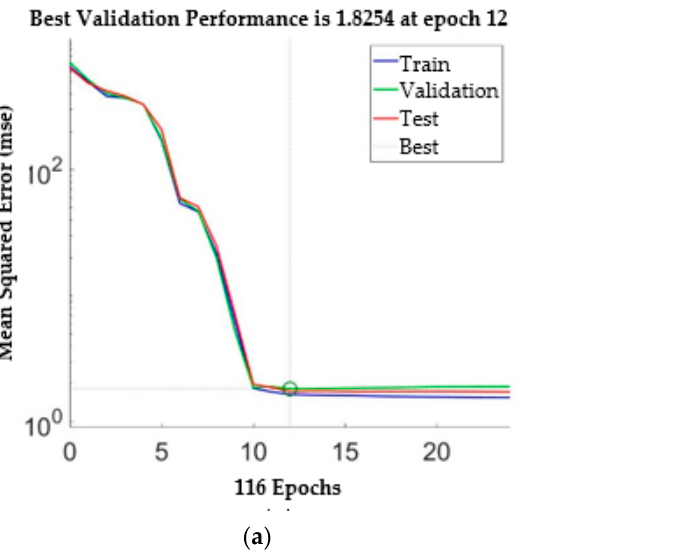
Figure 8. SLDM training. ( a ) MSE. ( b ) Regression results.